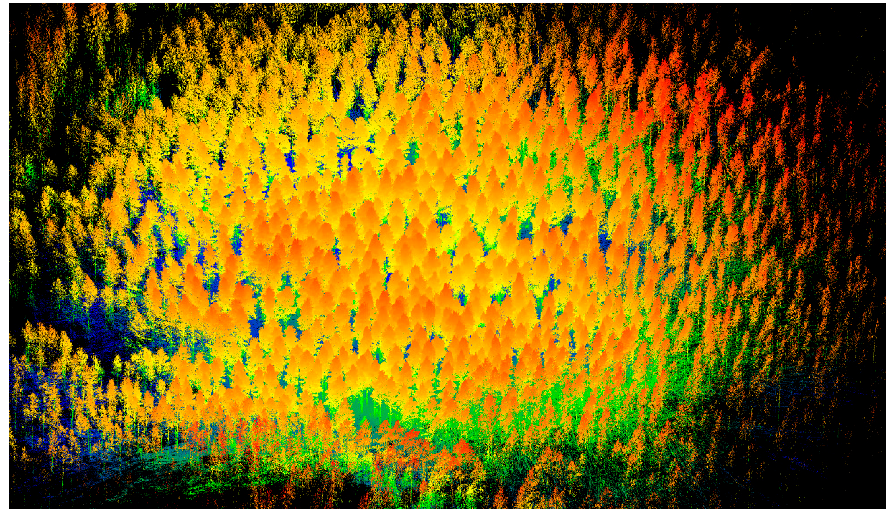
Figure 5. UAV-based point cloud from a forest. (The depicted plot is located in WGS84 coordinates 61°11 ′ N, 25°07 ′ E).